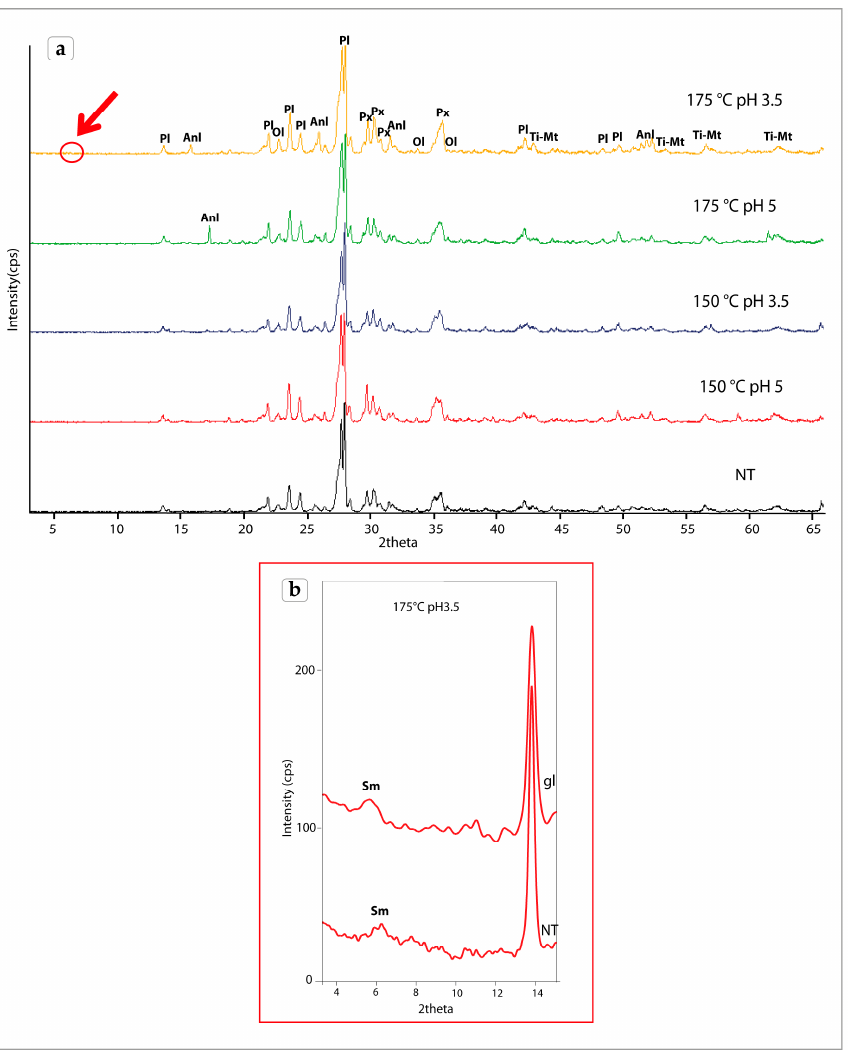
Figure 6. ( a ) XRD patterns of the sample powders, after different treatments. In comparison with the unaltered sample (black line), all the heated samples show a progressively decreasing intensity with temperature and acidity, of the diffraction peaks attributable to the main primary minerals as plagioclase (Pl), pyroxene (Px) olivine (Ol), and titano-magnetite (Ti-Mt) and the appearance of features diagnostic of both analcime (Anl) and smectite (Sm) ( b ) Zoom of the 2 θ interval around 6° (red circle) of the XRD pattern measured after the treatment at 175 °C and pH = 3.5 in the figure a showing the appearance of a diffraction peak at 14 Å, typical of clay minerals. The expansion of this peak to 17 Å after ethylene glycol solvation, point out the occurrence of smectite (Sm). NT = 175 ◦ C, at pH 3.5 untreated; gl = ethylene glycol. All the treatments shown here have been accomplished for 15